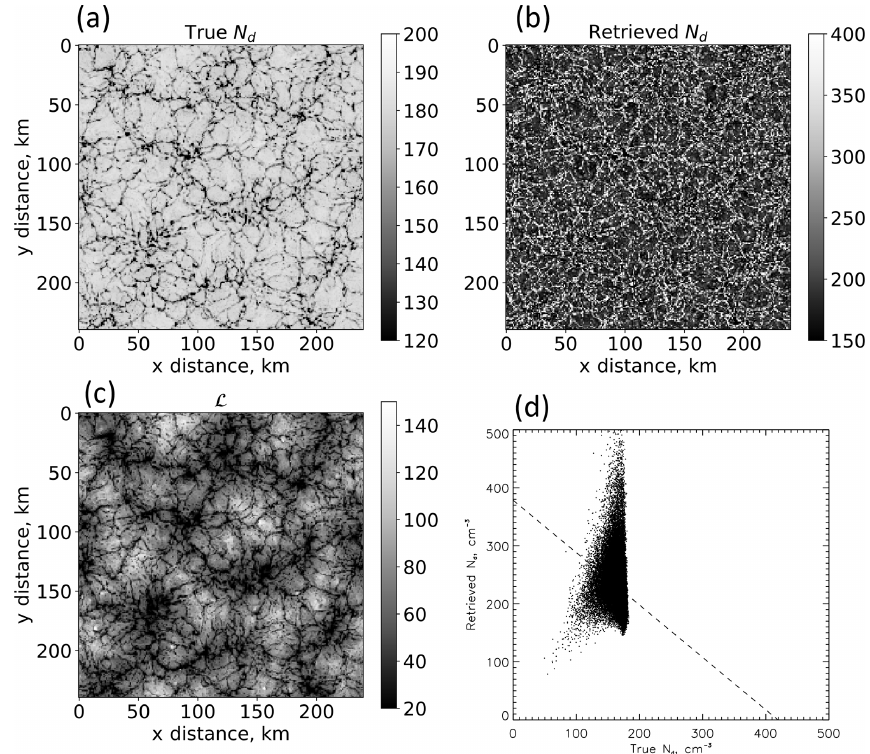
Figure 11. High-resolution ( n = 1) two-dimensional snapshot of (a) “true” N d , (b) retrieved N d (Eq. 2), (c) L , and (d) the relationship between (b) and (a) . Note the different scales between (a) and (b) . Although the mean values of N d in (a) and (b) differ by only − 36%, they exhibit negative correlation over the scene. The retrieved N d introduces significant heterogeneity into the field. Use of the true N d reduces the absolute value of the S o error from − 2017% to +